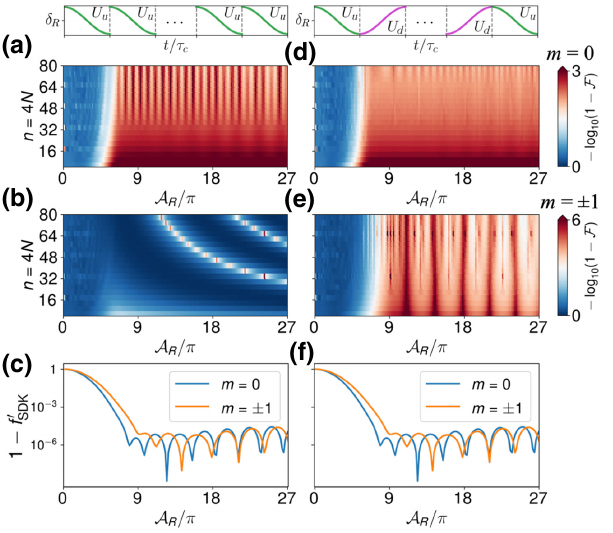
FIG. 12. Numerical results of gate infidelity 1 − F for the tra- FIG. 11. Numerical results of gate infidelity 1 − F for the tra- (left panels) and balanced chirp-alternating ˜ U ( 4 N ) ditional ˜ U ( 4 N ) uu ditional ˜ U ( 4 N ) (left panels) and balanced chirp-alternating ˜ U ( 4 N ) uu uddu (right panels) controls as those in Fig. 7, F = F ( 4 N ) (right panels) controls as those in Fig. 7, F = F ( 4 N ) , except for (cid:2) = − 6.6 ω m (cid:2) = − 6.6 ω HFS,g here. The corresponding two-photon detuning 85 Rb atom with nuclear HFS,g here and for a fictitious profiles are illustrated on top of spin I = 1.5. The two-photon detuning profiles are illustrated on top of (a),(d). The exceptionally high fidelity demonstrated in (e) is a result of m = ± 1 subspin degeneracy in the Raman control for a single kick is plotted dynamics. For comparison, 1 − f (cid:3) SDK in both (c),(f) by setting (cid:2) HFS, e = 0 to suppress the spin leakage according to Eq. (1).